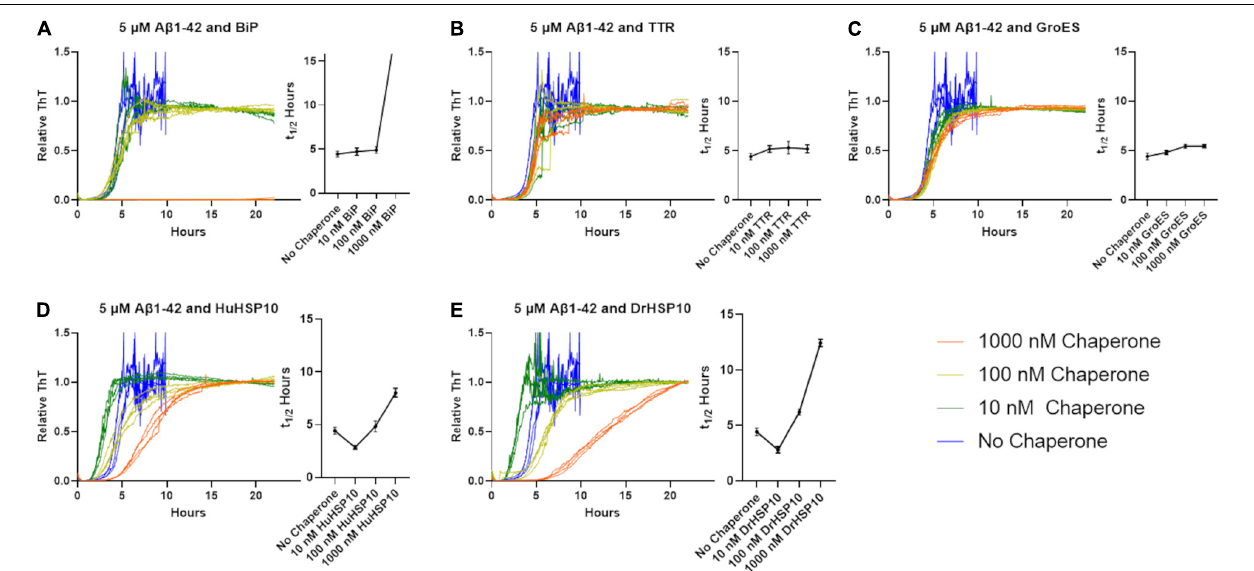
FIGURE 3 | Normalized Thioflavin T (ThT) traces of A β 1–42 fibrillation (5 µ M) when chaperones are present at various concentrations. Traces are colored according to the legend in the figure. Corresponding halftimes of fibril conversion, t 1 / 2 (hours), for each concentration are shown to the right in each panel. (A) A β 1–42 and BiP,